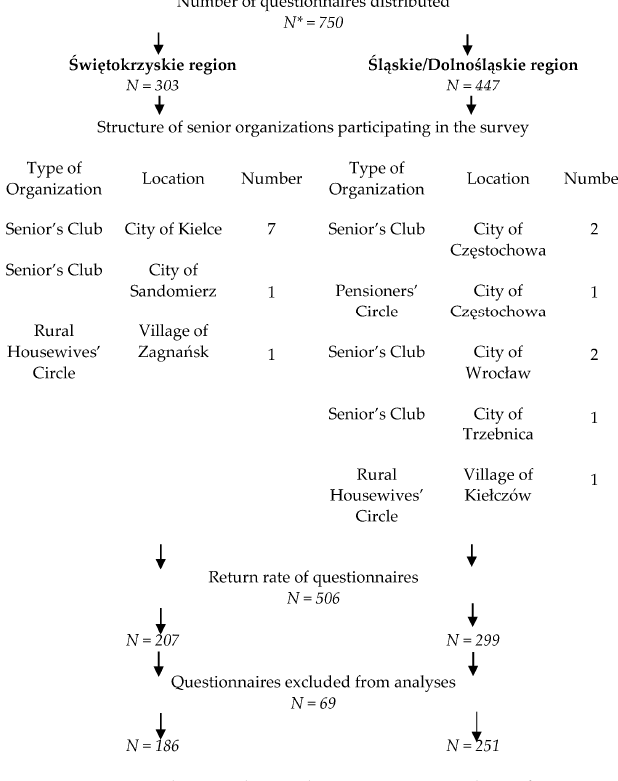
Figure 1. Research sampling scheme. * N —number of questionnaires.